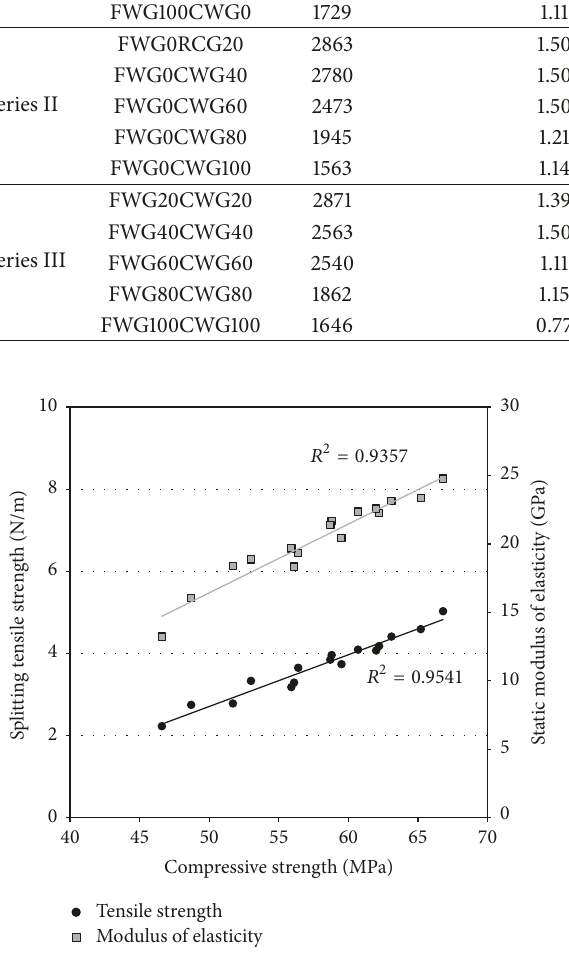
Figure 8: Splitting tensile strength and modulus of elasticity of SCC versus compressive